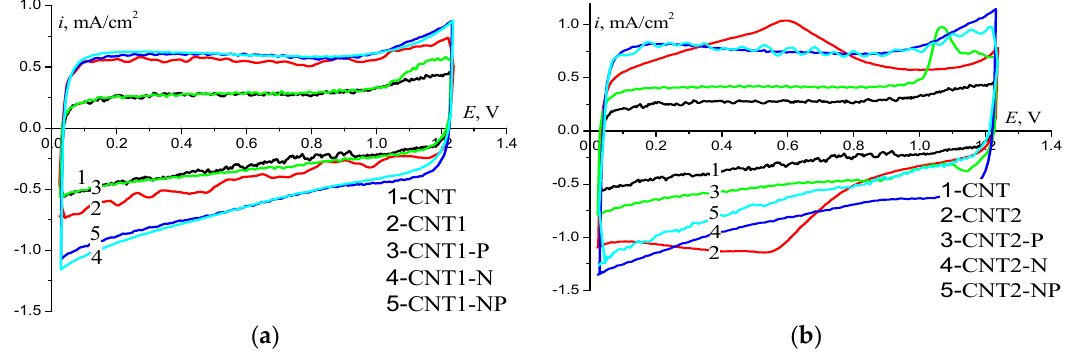
Figure 2. Cyclic voltammogram (CV) on CNTs doped with N and P. ( a ) –CNT functionalized with NaOH; ( b ) –CNT functionalized with HNO 3 . Ar-saturated 0.1 M KOH, the potential scan rate is 100 mV/s; m cnt = 0.15 mg/cm 2 .